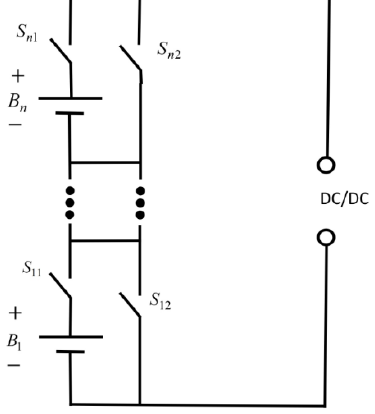
Figure 7. The structure of switch network.